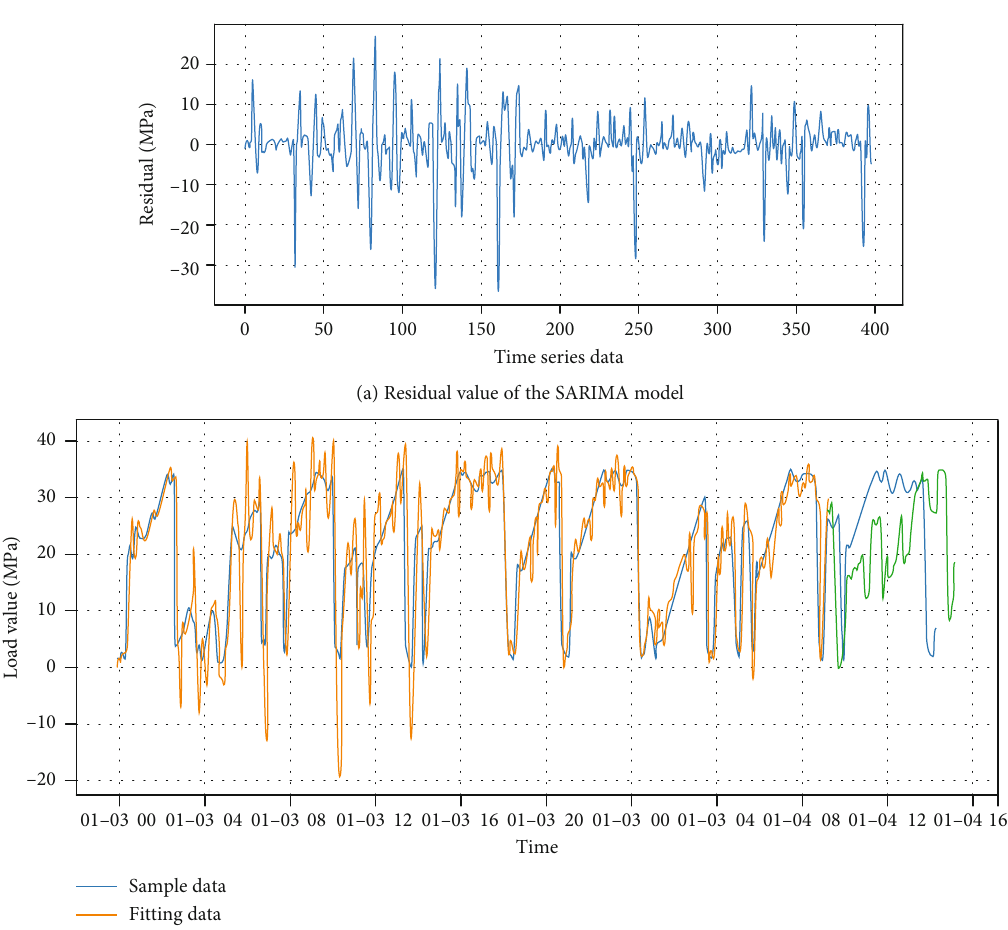
Figure 11: The residual value and prediction result of the SARIMA